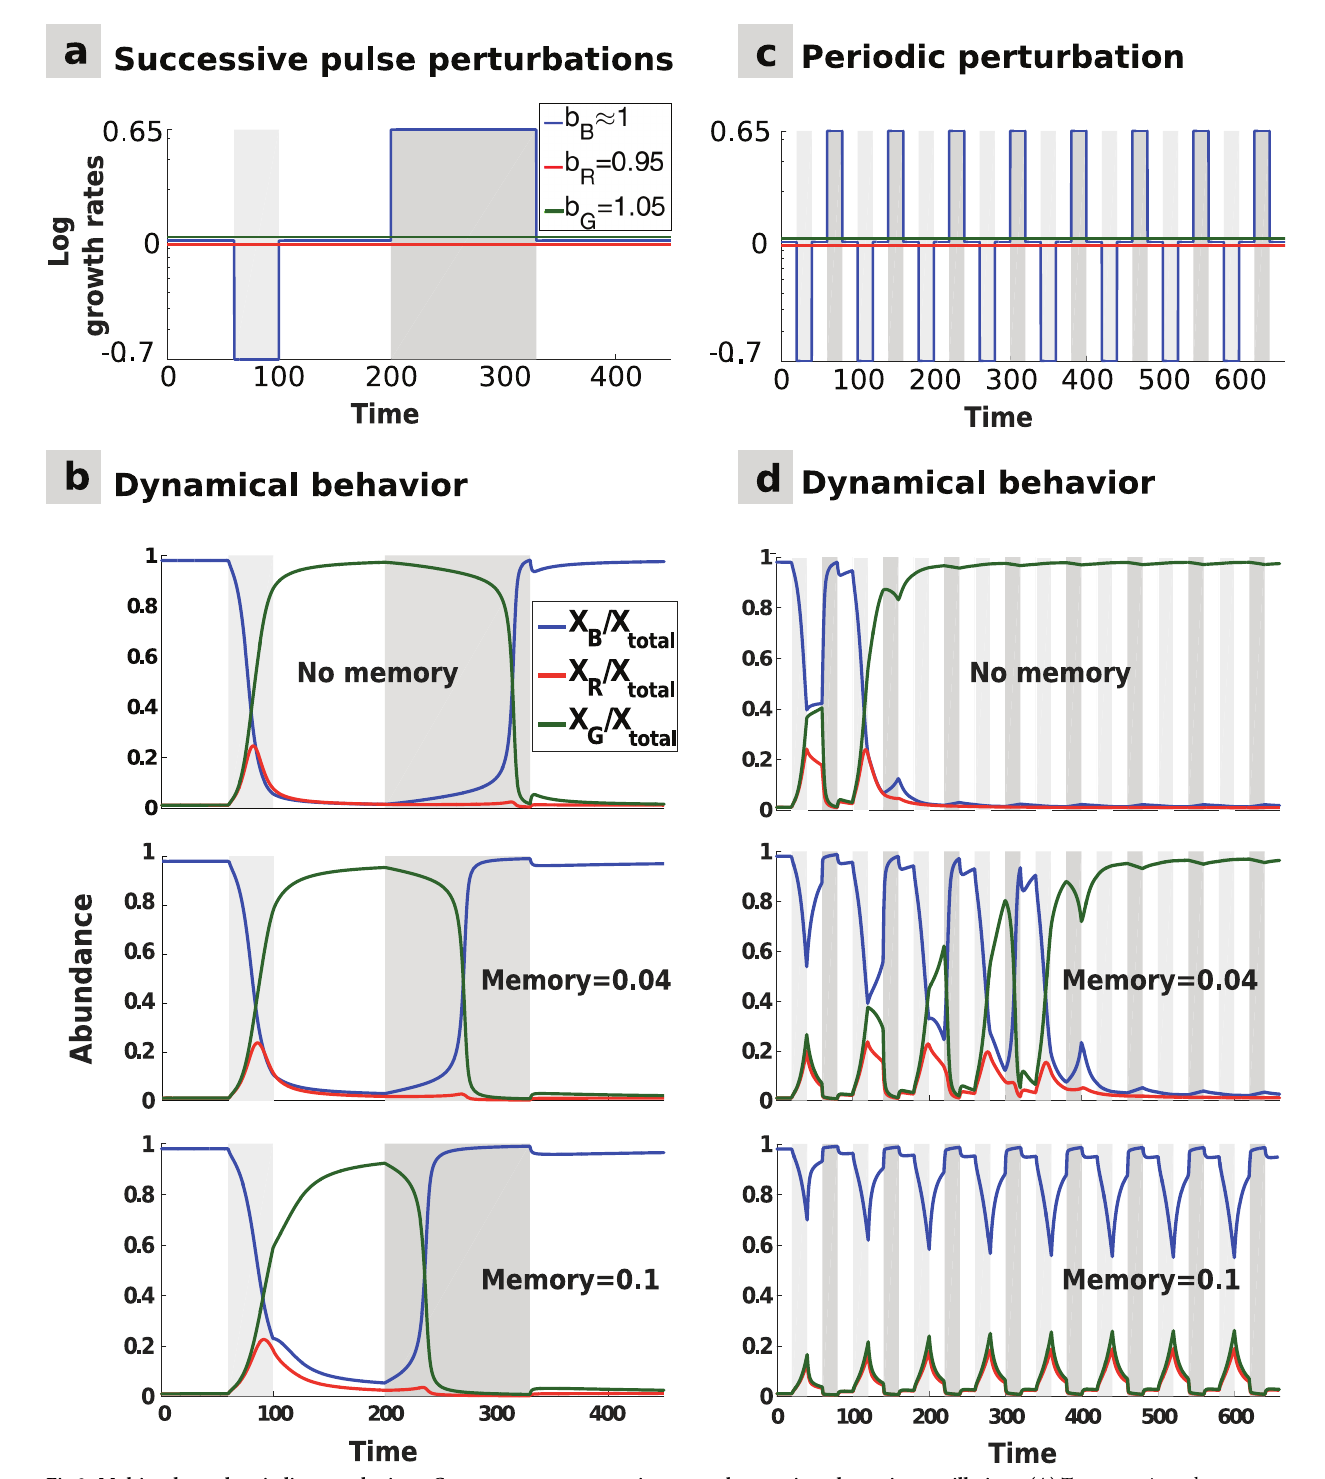
PLOS Computational Biology | https://doi.org/10.1371/journal.pcbi.1009396 June 3,